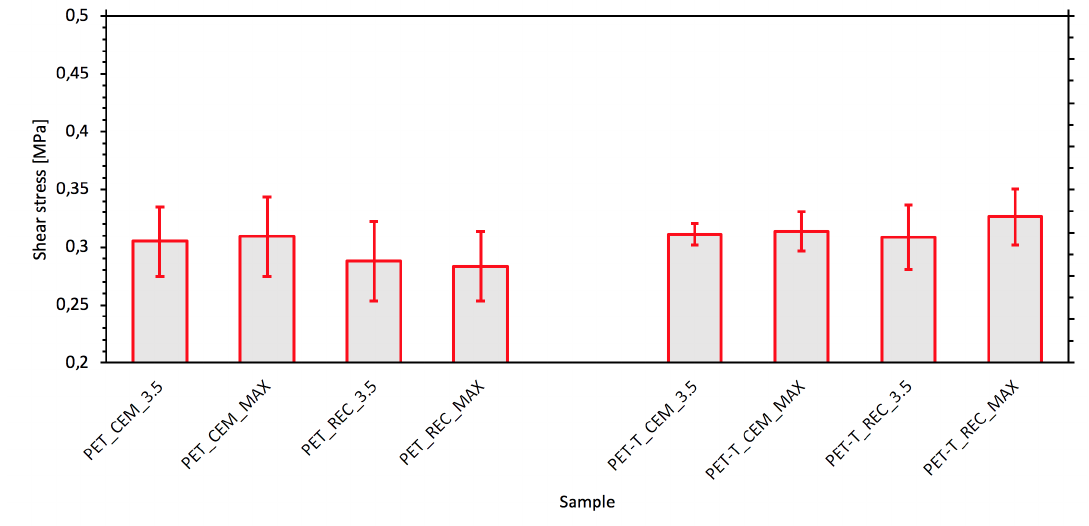
Figure 4. Interfacial shear stress values for different combinations of matrices and PET fibers calculated from the pull-out